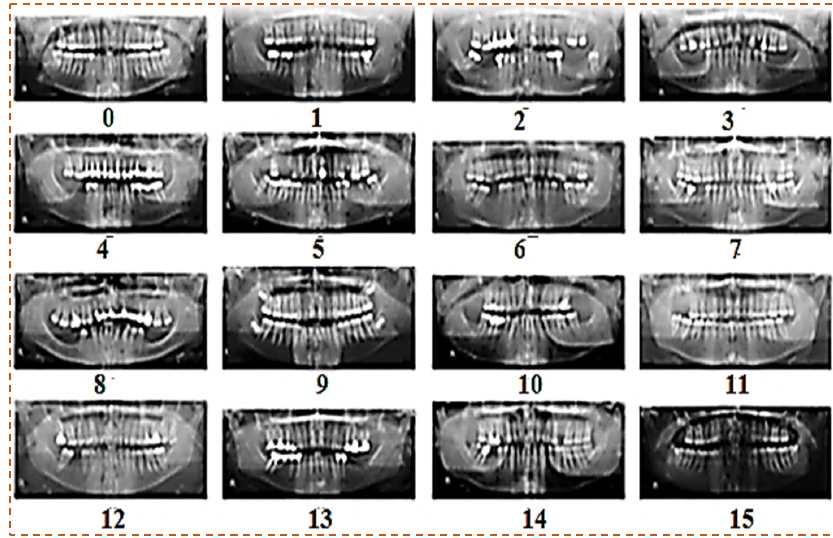
Figure 2. Custom dataset of panoramic X ‐ rays.